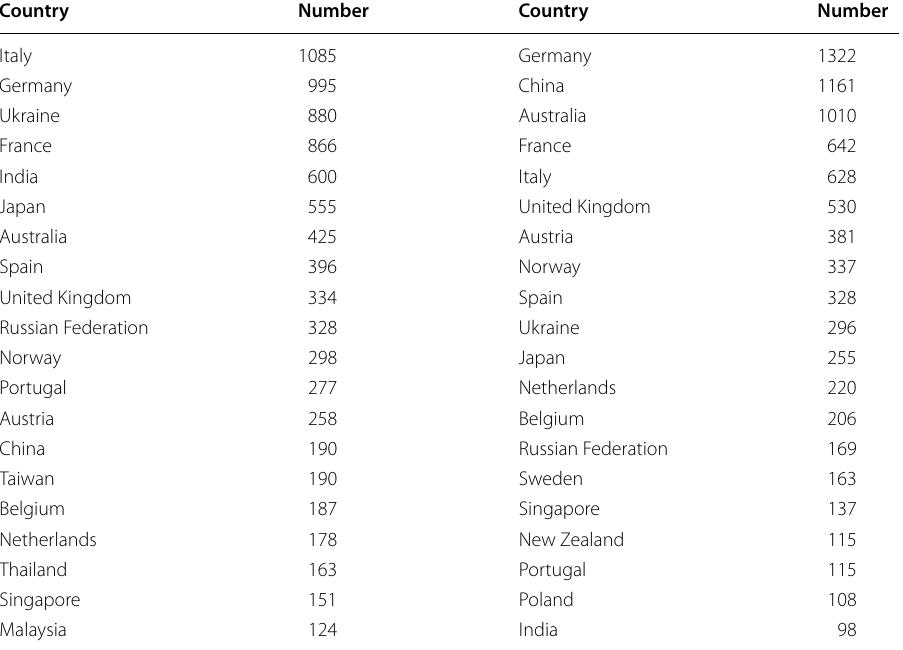
Table 5 Top 20 influential countries using coreness on the RIG (left) and influence maximization on the IM on the total network of entities (right) Country Number Country Number